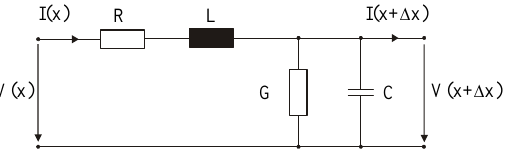
Figure 4. Electric equivalent circuit of an infinitesimal section of a TEM transmission